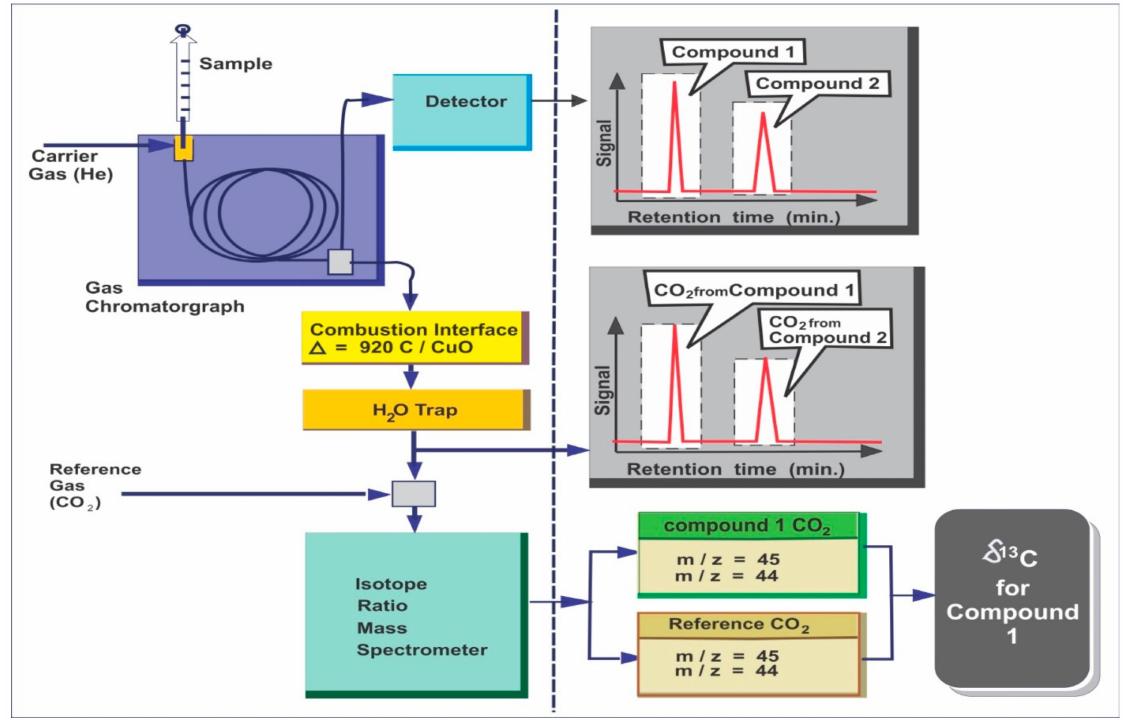
Figure 1. Schematic diagram of GC-IRMS system (modified from